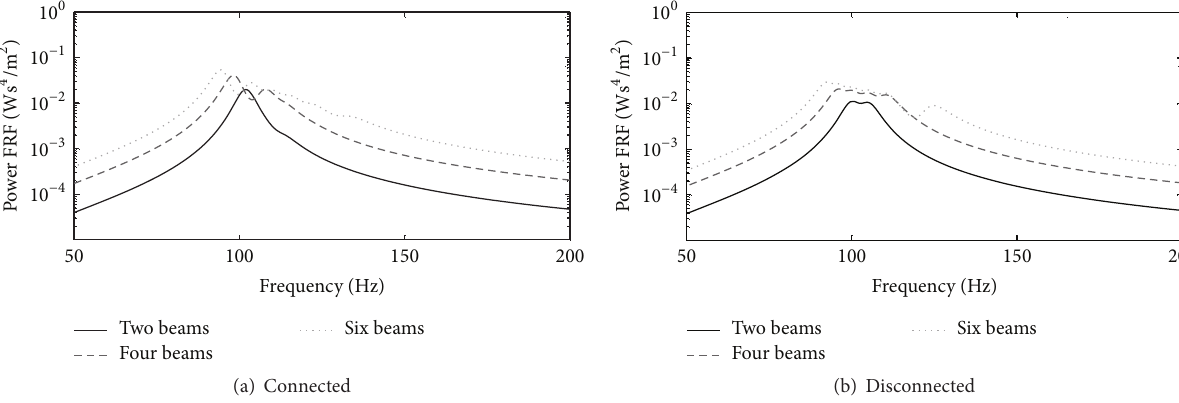
Figure 7: Power FRF with an increasing number of bimorph beams with different tip masses. Two beams: 𝑀 𝑡,1 = 0.3𝑚𝐿 , 𝑀 𝑡,2 = 0.35𝑚𝐿 , = 0.25𝑚𝐿 , 𝑀 = 0.30𝑚𝐿 , 𝑀 = 0.35𝑚𝐿 , 𝑘 = 0.3𝑌𝐼/𝐿 3 ; six beams: 𝑀 𝑘 = 0.3𝑌𝐼/𝐿 3 ; three beams: 𝑀 𝑡,1 𝑡,2 𝑡,3 1,2 = 0.30𝑚𝐿 , 𝑀 = 0.35𝑚𝐿 , 𝑀 = 0.40𝑚𝐿 , 𝑀 = 0.45𝑚𝐿 , 𝑘 = 0.3𝑌𝐼/𝐿 3 . 𝑀 𝑡,3 𝑡,4 𝑡,5 𝑡,6 𝑖=1,...,5